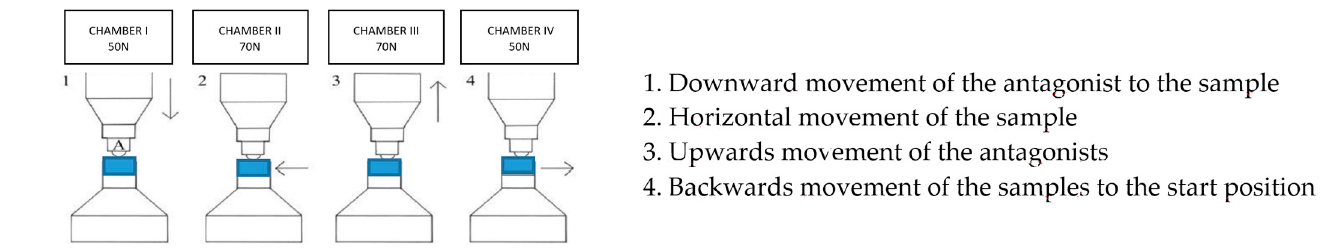
Figure 3. The algorithm of linear movement of a chewing simulator and the distribution of the load in the test chambers: An Antagonist, Crown .